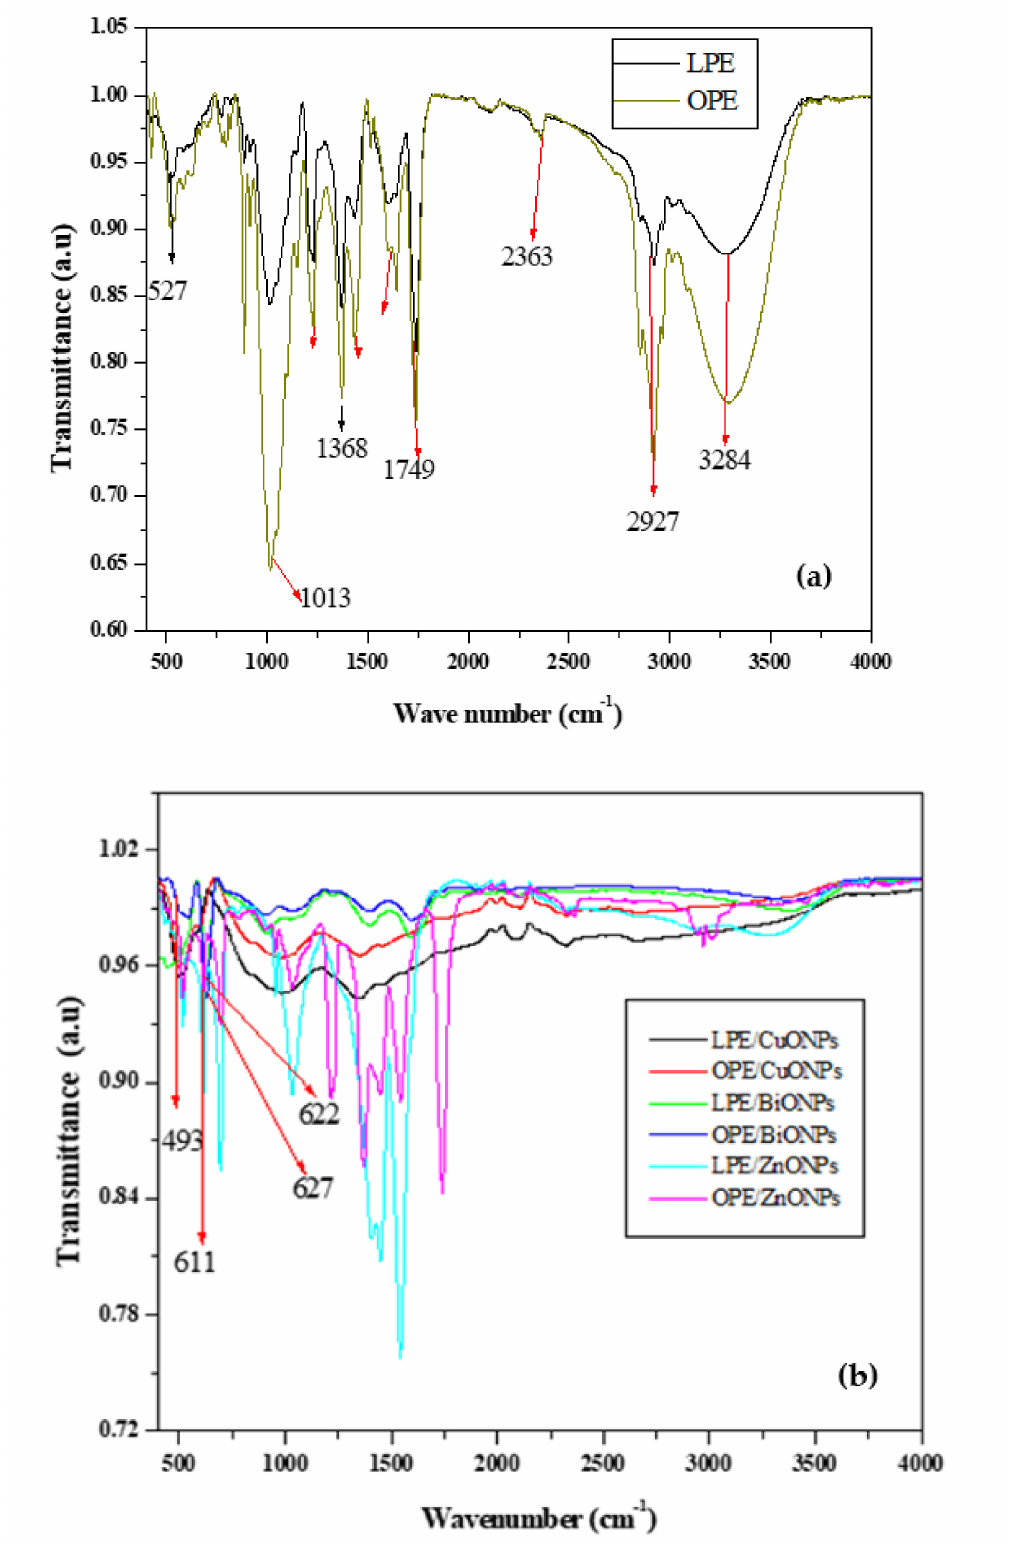
Figure 2. FTIR spectral of ( a ) citrus peels extract (CPE) and ( b )